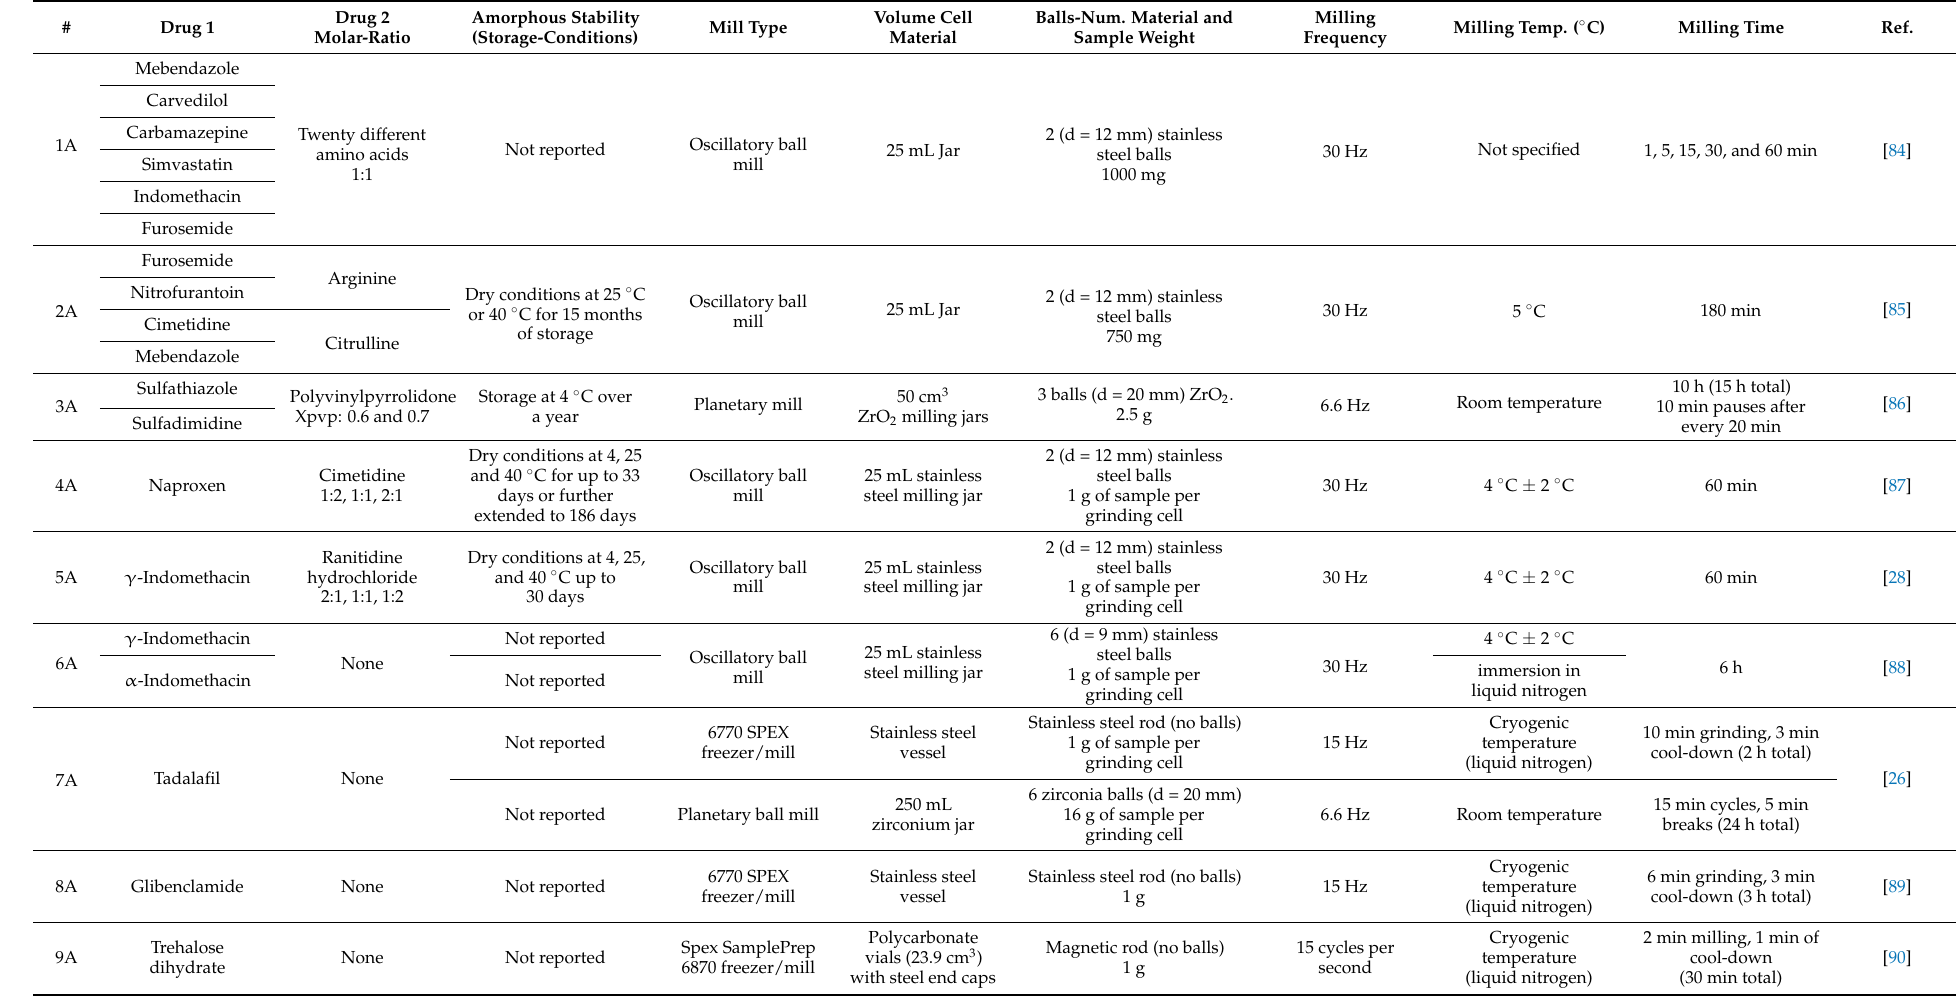
Table 1. Conditions of preparation of co-amorphs by ball milling